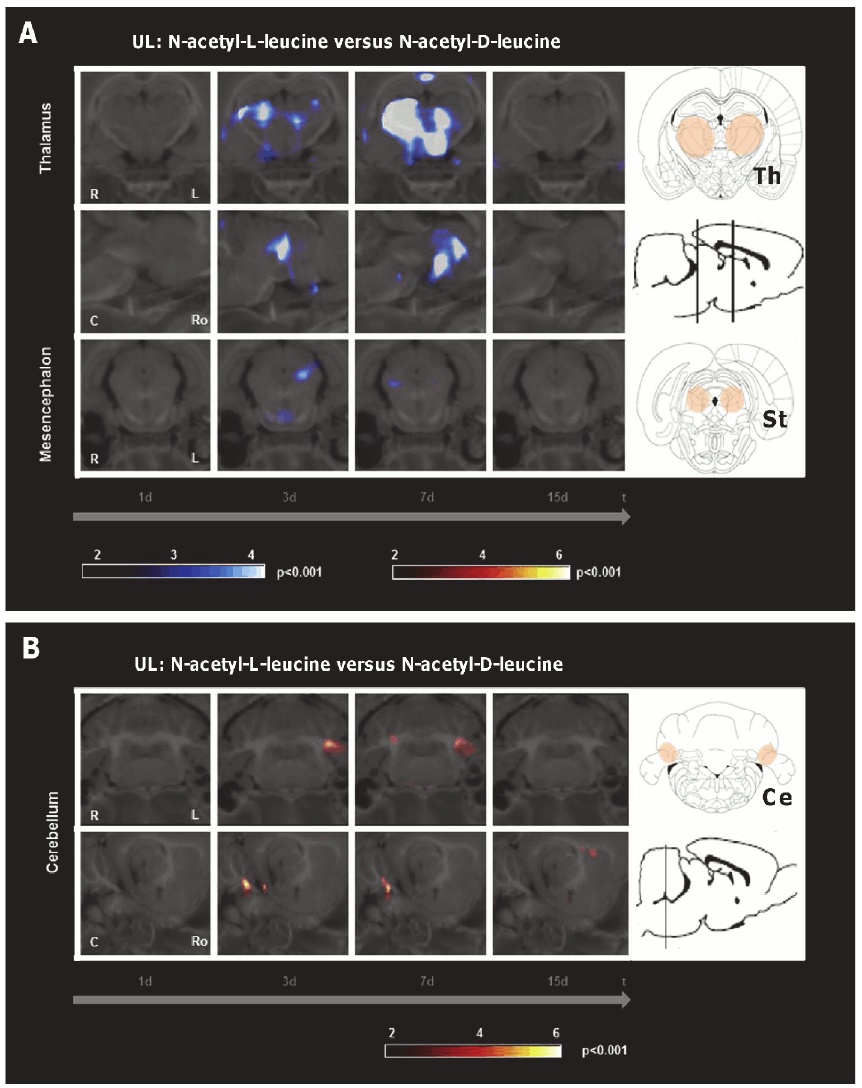
Fig 6. Regional cerebral glucose metabolism after N-acetyl-L-leucine as compared to N-acetyl-D- leucine treatment following unilateral labyrinthectomy. The images depict group-wise comparisons of the regional cerebral glucose metabolism (rCGM) on days 1, 3, 7 and 15 after unilateral labyrinthectomy (UL). A) Comparison of the N-acetyl-L-leucine group and the N-acetyl-D-leucine group (24 mg i.v. per rat each) revealed a significant decrease of rCGM in the contralesional > ipsilesional posterolateral thalamus on day 3 and 7. B) On day 3 rCGM was significantly increased in the ipsilesional, on day 7 in the ipsilesional > contralesional paraflocculus/flocculus (vestibulocerebellum) in the N-acetyl-L-leucine group. R right, L left, C caudal, Ro rostral, Ce cerebellum, St subthalamic region, Th thalamus; p-value <